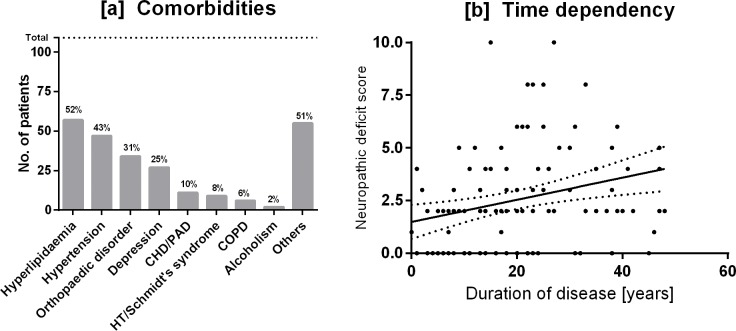
(a) Co-morbidities (N,%) in type 1 diabetes patients (N = 109). CHD, coronary heart disease; PAD, peripheral artery disease; HT, hypothyreoidism; COPD, chronic obstructive pulmonary disease, and (b) correlation of NDS (neuropathic deficit score) with duration of disease (ρ = 0.368, p<.01).